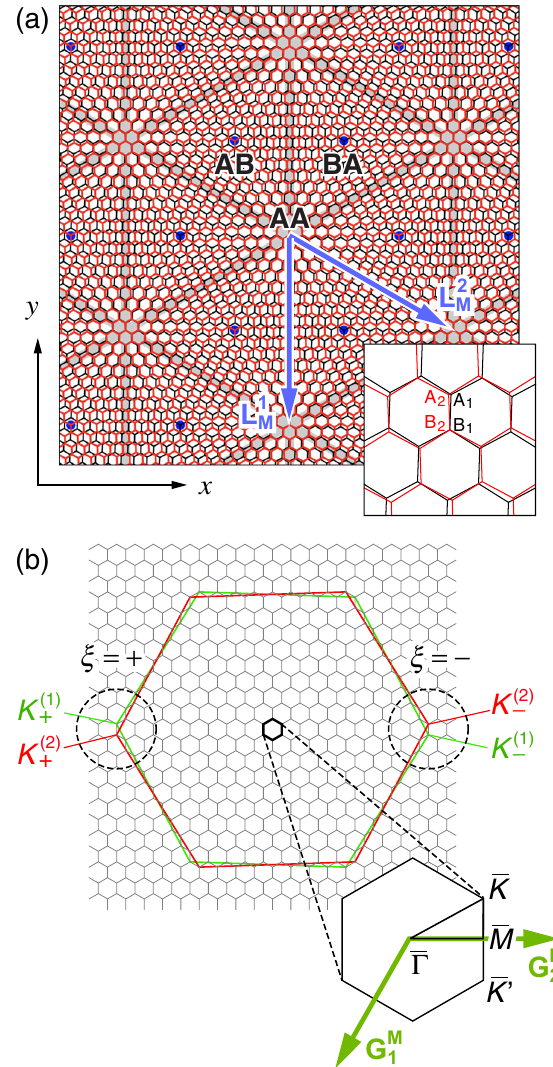
FIG. 1. (a) Atomic structure of TBG with θ ¼ 3 . 89 ° and D 3 symmetry. AA spots are located at the crossing points of the grid lines, and AB and BA spots are at the centers of triangles indicated by dots. (b) Brillouin zone folding in TBG with θ ¼ 3 . 89 °. Two large hexagons represent the first Brillouin zones of graphene layers 1 and 2, and the small hexagon is the moir´e Brillouin zone of